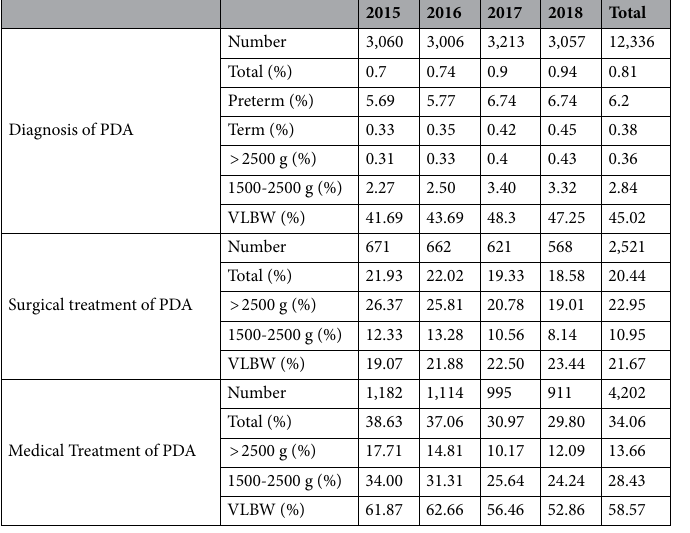
Table 1. Prevalence of PDA Diagnosis, surgical ligation, and pharmacological intervention according to the birth weight group. Abbreviations: PDA, patent ductus arteriosus; VLBW, very low birth weight. (% value is calculated from denominator of total birth in the relevant year).